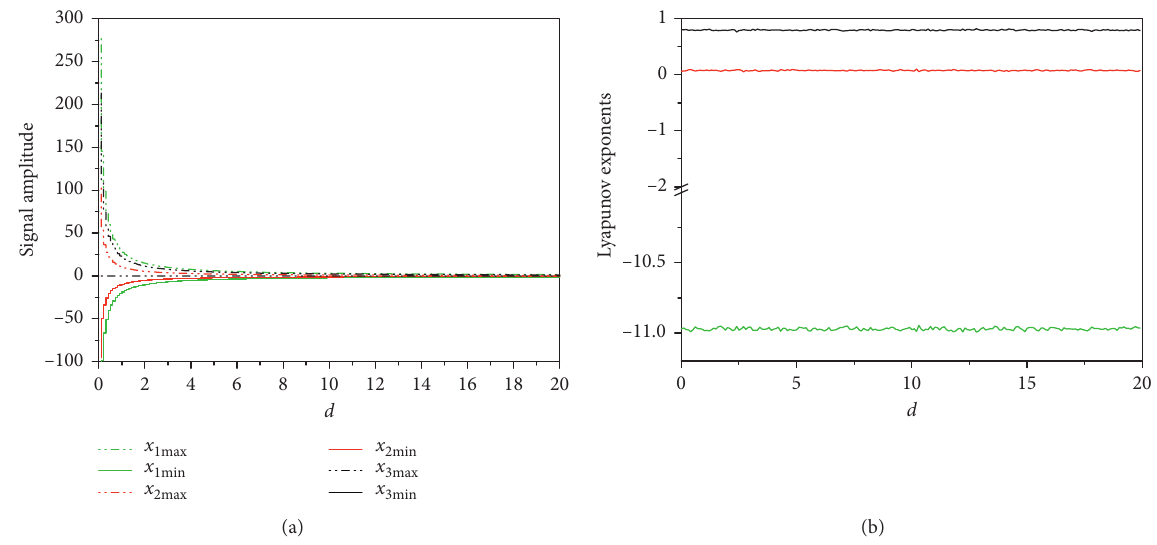
Figure 11: (a) Signal amplitude and (b) finite time Lyapunov exponent spectrum versus d